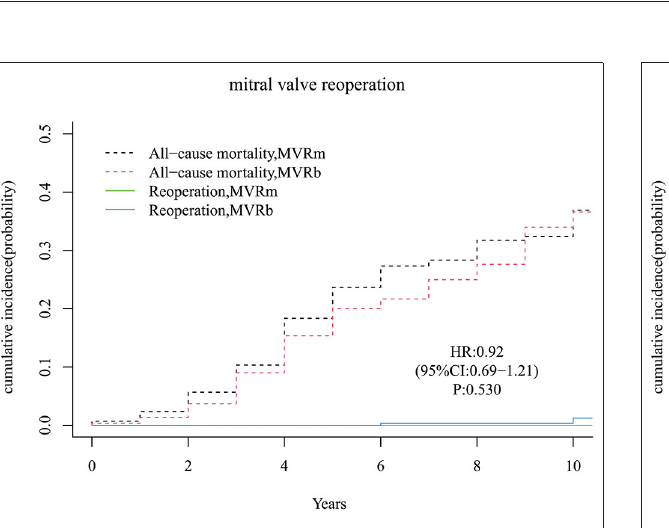
FIGURE 4 | Cumulative incidence of infective endocarditis. MVRm, mechanical mitral valve replacement; MVRb, bioprosthetic mitral valve replacement.